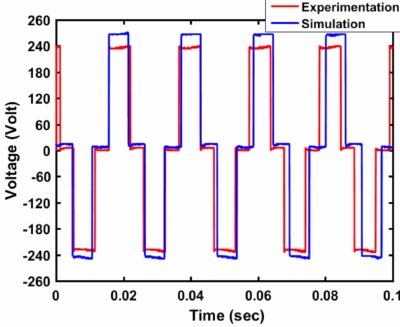
Figure 16. Battery Lifetime comparison between proposed and conventional model.